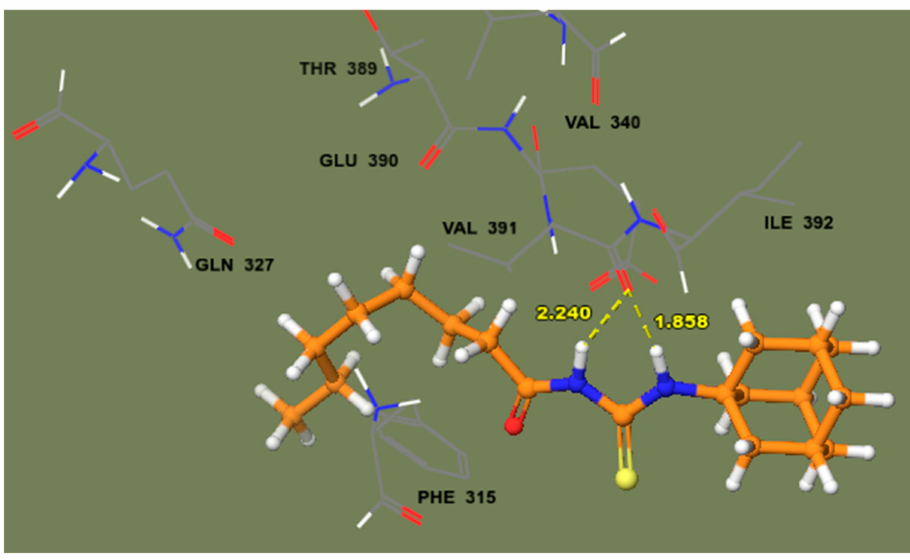
Figure 8. The docking complex of 3j with urease enzyme (PDBID 4H9M) showed binding interaction with VAL391 located outside the catalytic site of